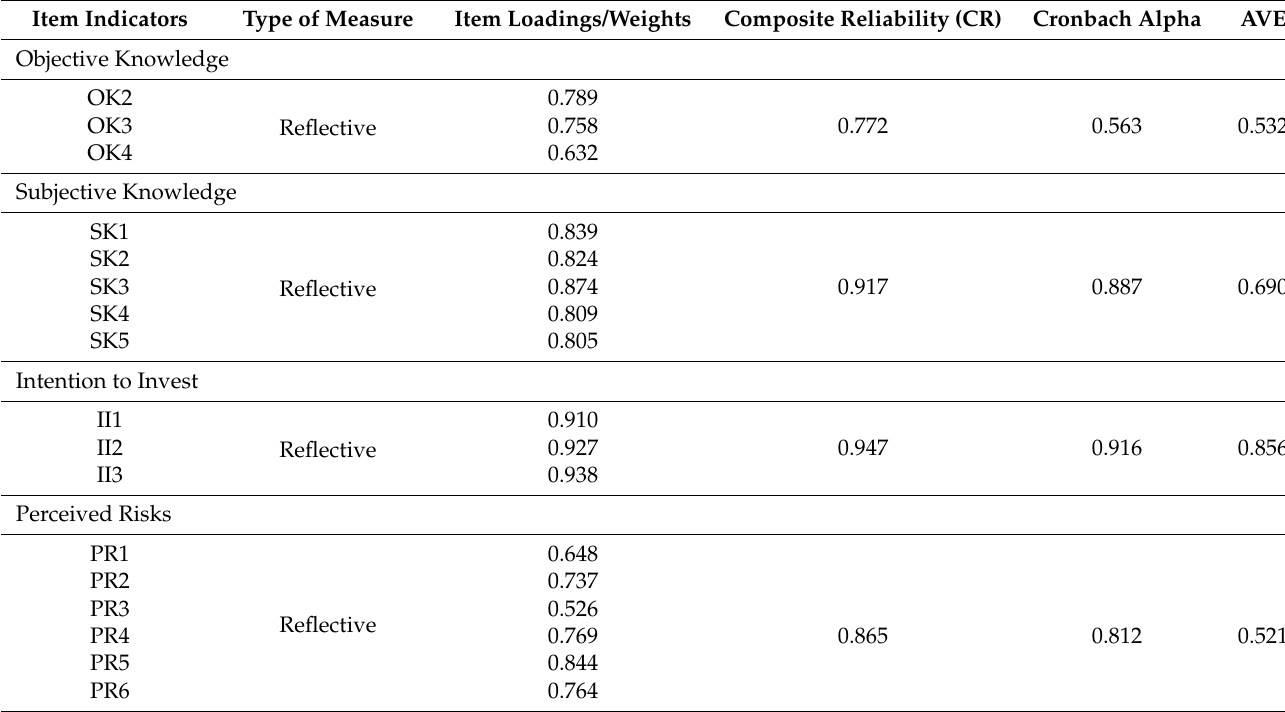
Table 3. Convergent validity.